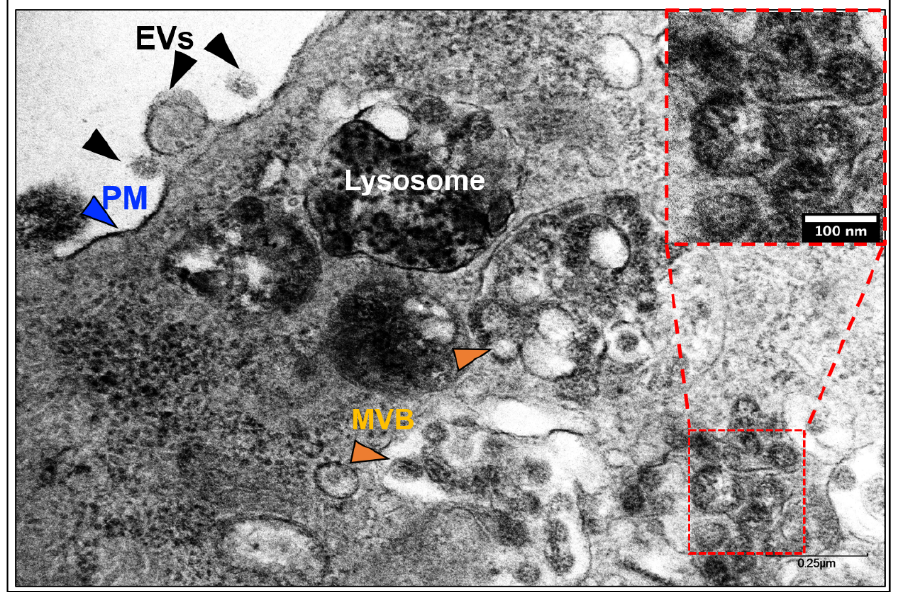
Figure 2. Transmission electron microscopy (TEM) of SARS-CoV-2-infected Vero E6 cells. Exosomes and/or a SARS-CoV-2-like particle can be seen (inset) inside an MVB. Evs—extracellular vesicles, PM—plasma membrane, MVB—multivesicular bodies. PM—plasma membrane, MVB—multivesicular